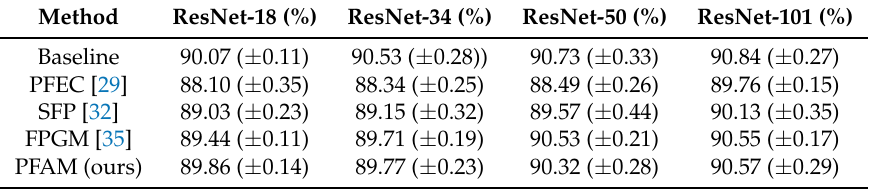
Table 4. Accuracies (%) of pruning ResNet based on the pretrained model on the AID dataset.